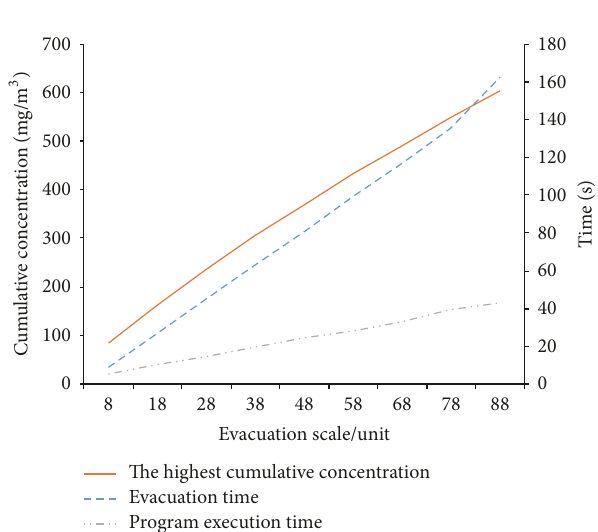
Figure 5: The diagram of program execution time in 100 tests.